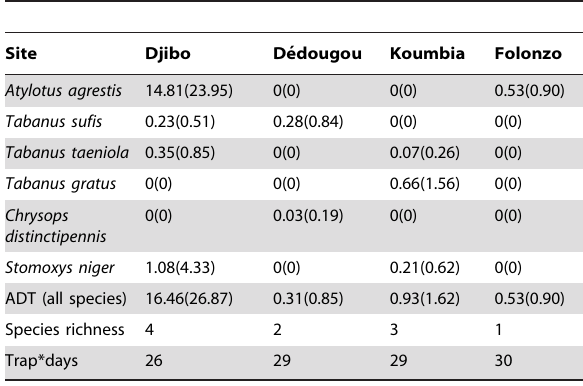
Table 3. Apparent densities of mechanical vectors along the climatic gradient.